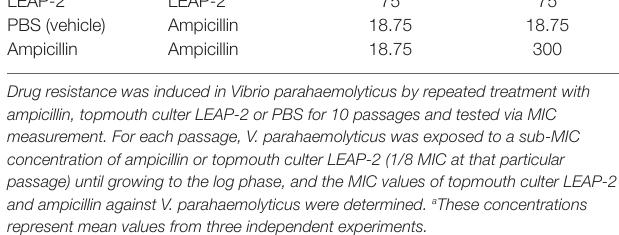
sub-MIC concentration of ampicillin (1/8 MIC at that particular passage) and a constant concentration of topmouth culter LEAP-2 (18.75 μ g/ml, 1/4 MIC of LEAP-2 against V. parahaemolyticus) until growing to the log phase, and the MIC values of ampicillin against V. parahaemolyticus were determined via MIC assay. a These concentrations represent mean values from three independent experiments.